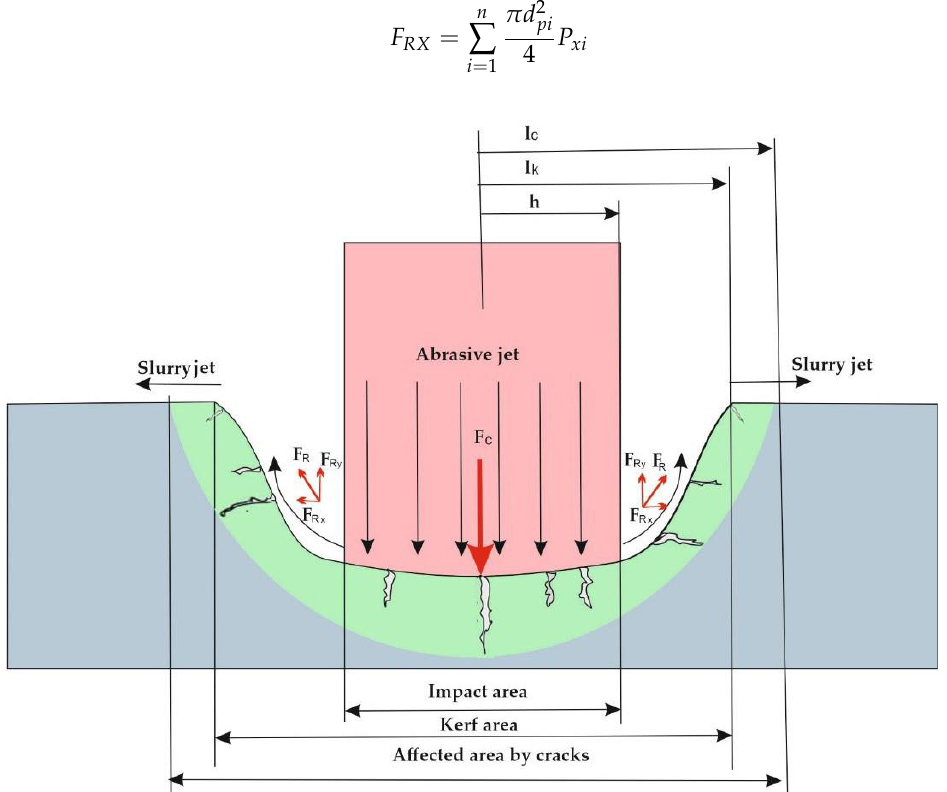
Figure 3. Action of slurry jet on lateral direction.